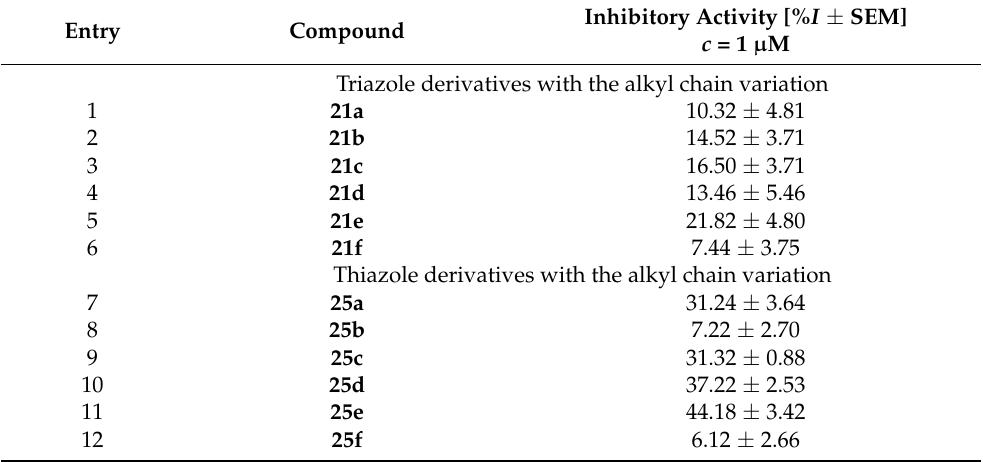
Table 3. Inhibitory activities of the prepared triazole and thiazole-based amino ketones in the SAR